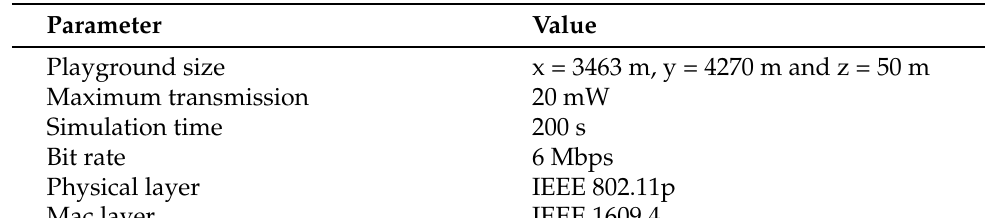
Table 5. Simulation Environment Parameters.